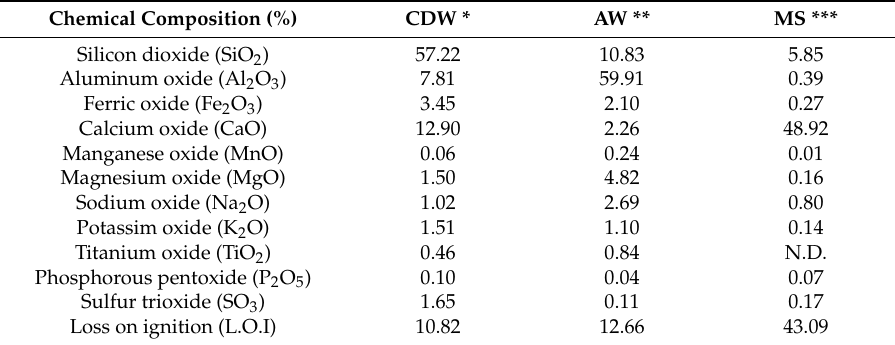
Table 4. Chemical composition of the